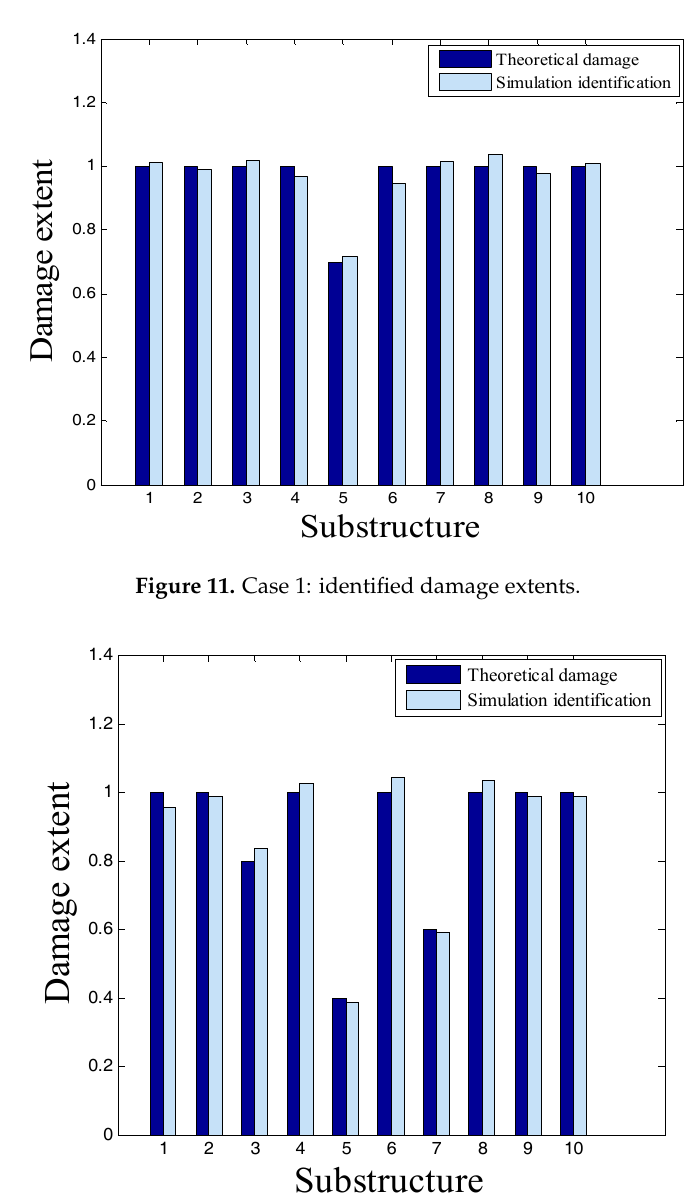
Figure 12. Case 2: identified extents of damage.